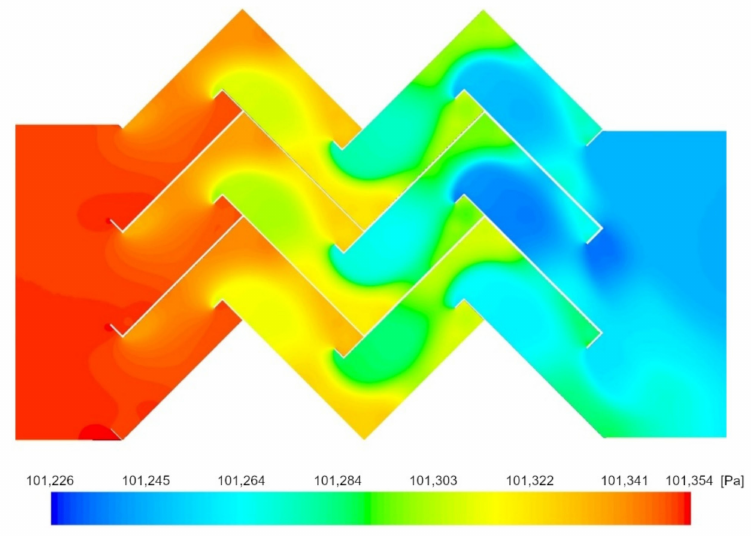
Figure 16. Pressure fields (Pa) of B_15_0 geometry for inlet velocity 2 m s − 1 simulated using a transition SST